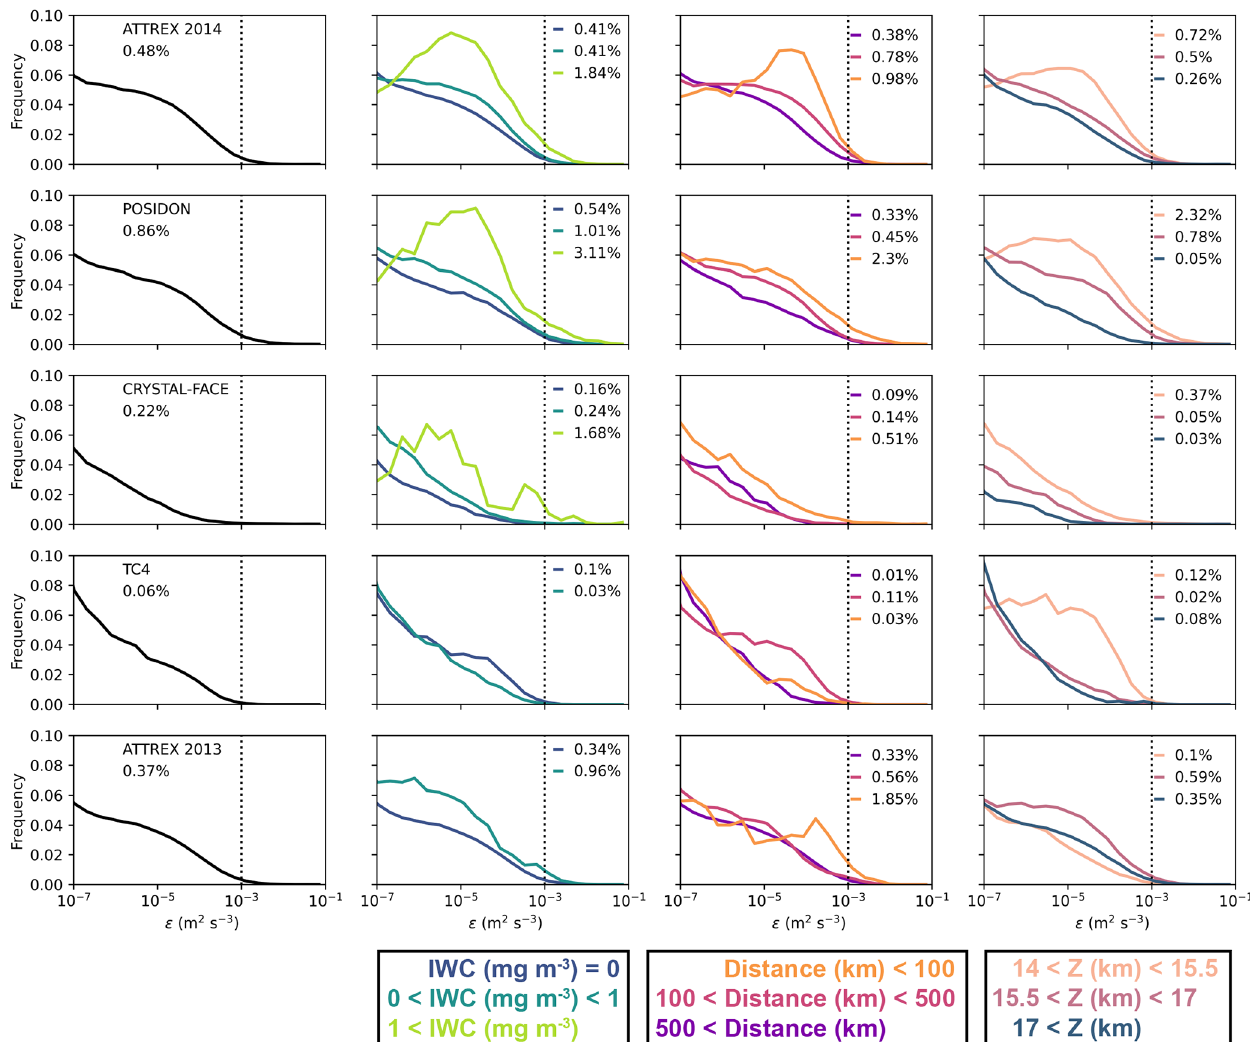
Figure B3. Same as Fig. 4 but with distributions of (cid:15) instead of σ 2 w 1 as a proxy for turbulence. A threshold of 10 − 3 m 2 s − 3 is used as the turbulence